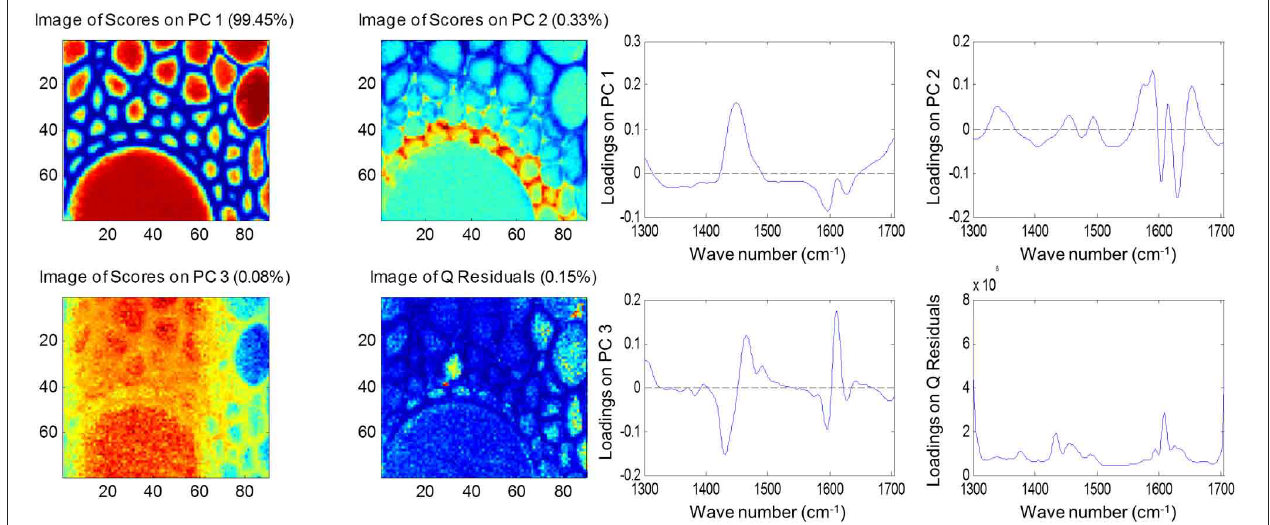
FIGURE 2 | Principal component analysis of Raman spectra maps of sections of mature maize stem internode. Score images (left) and loading plots (right) are shown for the first three components together with the score image and loadings for the Q residuals (variance